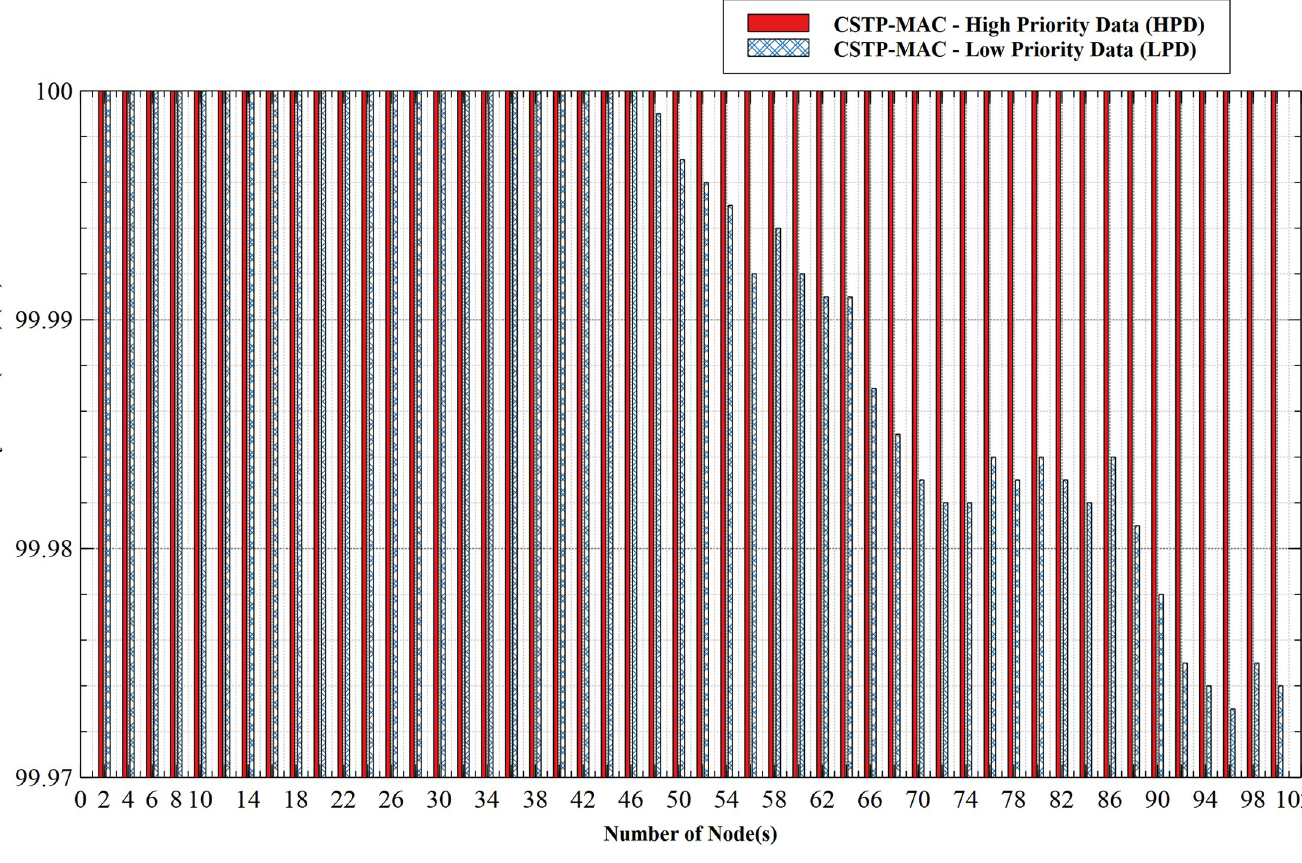
Fig 9. Packet delivery ratio (PDR)–HPD vs